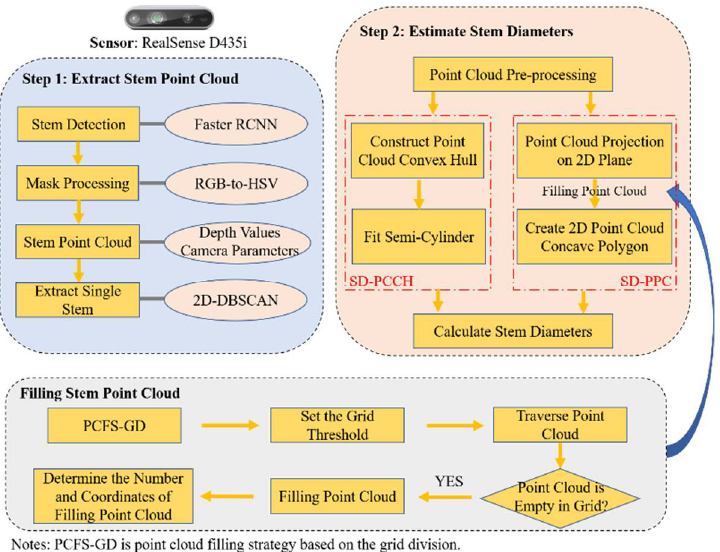
Figure 4. The comprehensive framework for calculating the stem diameters.